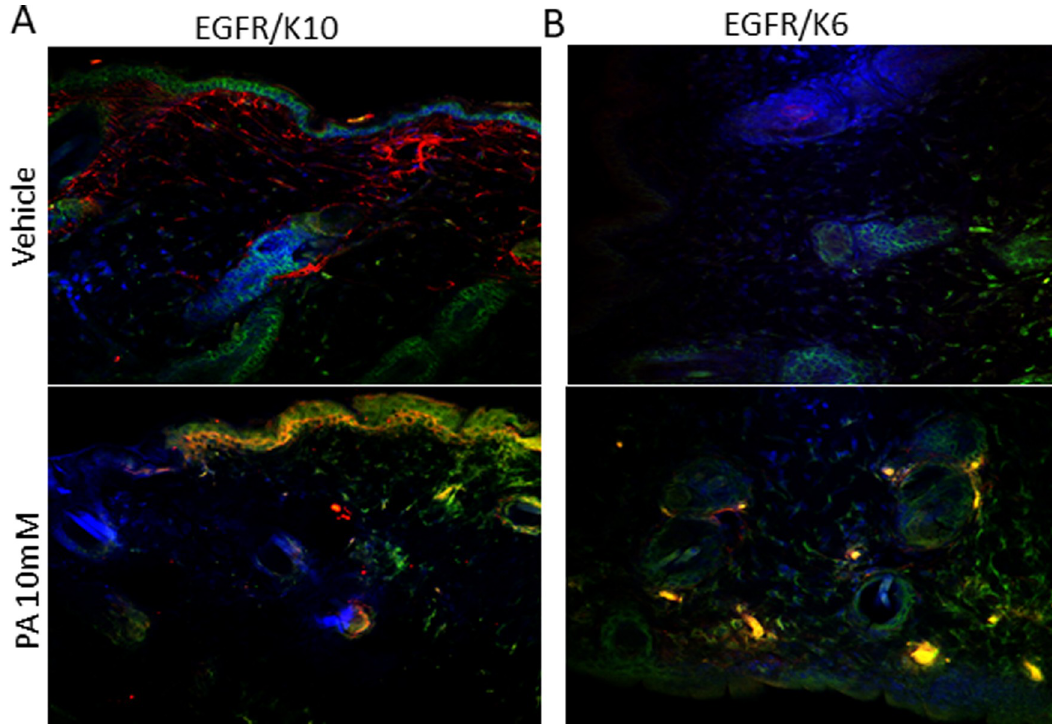
Fig 6. Immunofluorescence of the wounds on day nine treated with 10 mM PA vs. vehicle. Cytokeratin 10 staining for keratinocytes (green) and EGFR (red) (A). Cytokeratin 6 staining for keratinocytes (green), EGFR (red) and the merge (yellow) (B). DAPI labeling nuclei (blue). Representative of three distinct